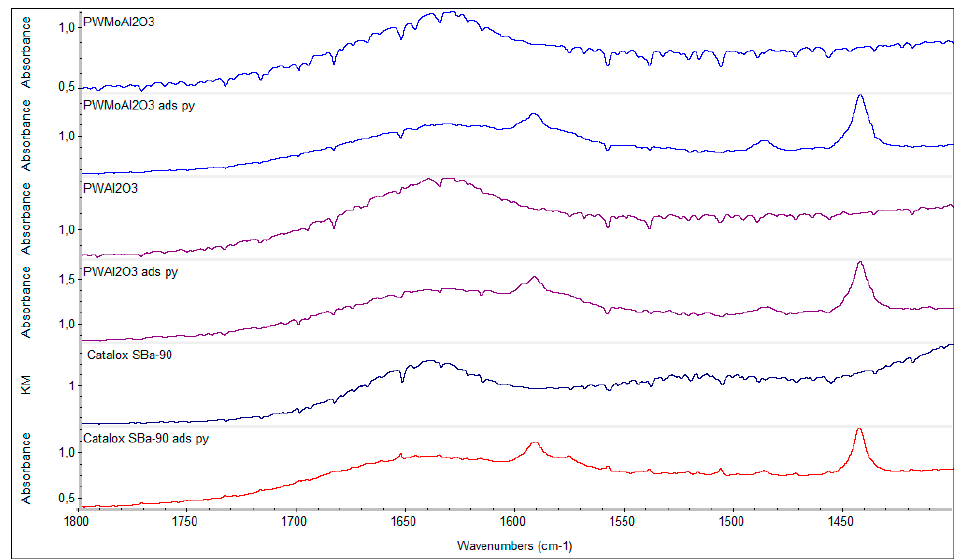
Figure 3. FT-IR spectra of pyridine adsorption on Catalox-SBa90, PWAl 2 O 3 , and PWMoAl 2 O 3 .